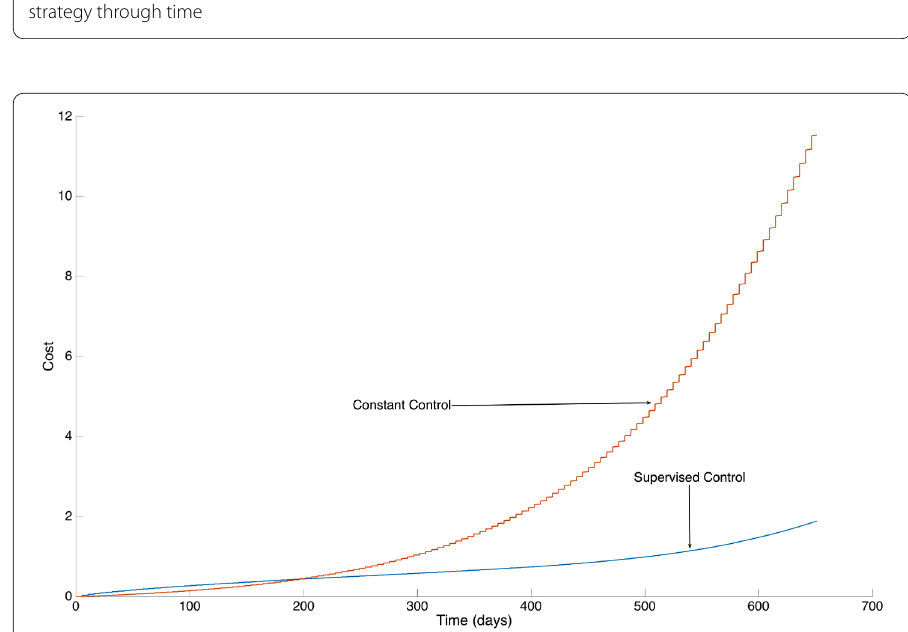
Figure 4 A comparison between supervised control and a constant control strategies